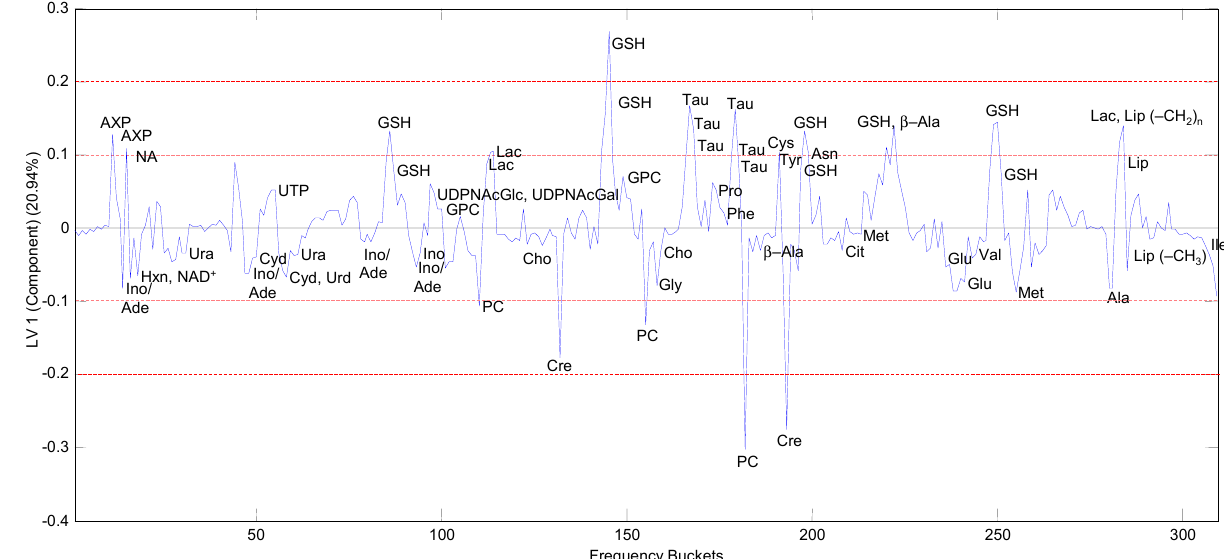
Figure 5. PLS-loadings of the first PLS component (LV-1), which was mainly separating the samples according to resistance. Positive LV components indicate higher metabolite concentrations in cells with increased cisPt resistance. The red lines are arbitrary lines marking thresholds of load values ± 0.1 and ± 0.2 above or below which metabolites are considered as strong contributors to separation.